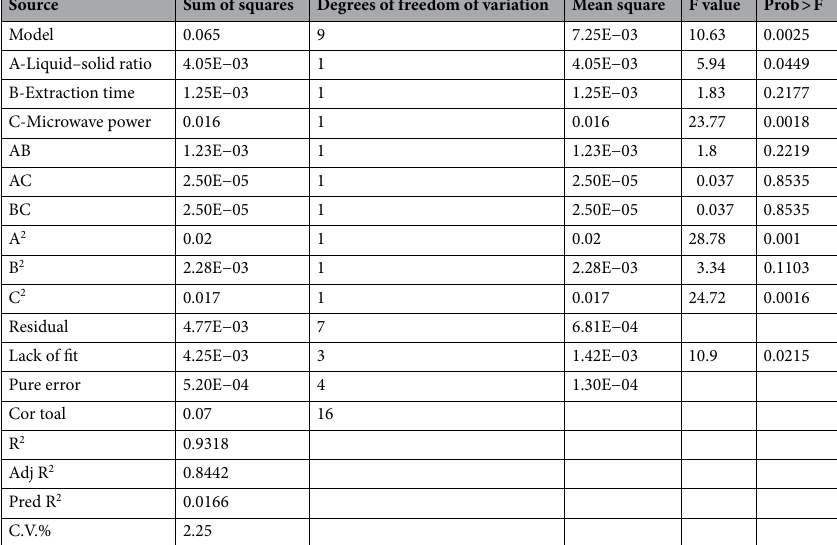
Table 5. Analysis of variance for the regression model. Values of “Prob > F” less than 0.05 indicate that the model terms are significant, and values greater than 0.10 indicate that the model terms are not significant.